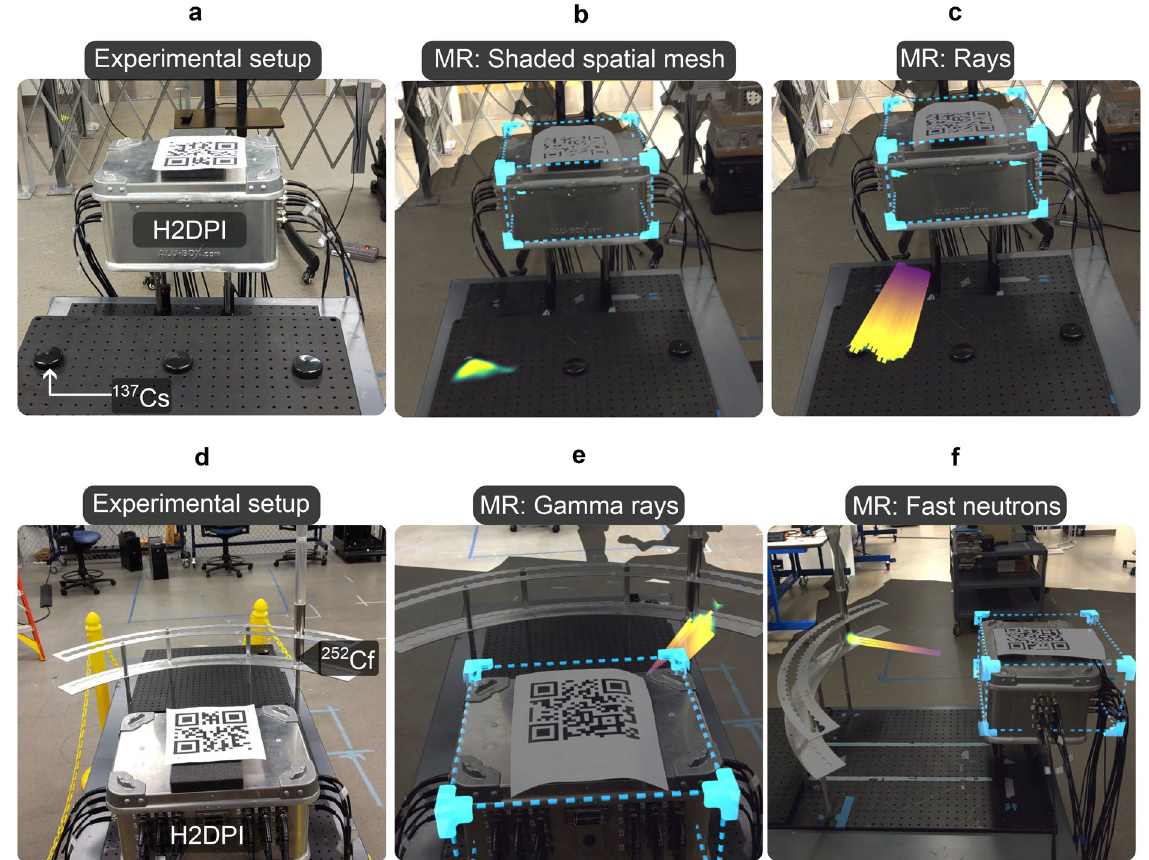
Figure 3. Examples of the mixed reality visuals as seen by the user wearing the HoloLens2. ( a ) A 100 µ Ci 137 Cs source is set under one of three caps in front of the detector system. ( b ) In MR, the user is shown a coloring of the spatial mesh after about 30 seconds of acquisition. ( c ) The user may optionally choose to also display rays that point to the hot spot. ( d ) A 1 mCi 252 Cf source in front of the system. ( e ) The gamma ray image forms within approximately 20 seconds. ( f ) The user can switch to the (simultaneously acquired) neutron image via a wrist menu. A converged neutron image that intersects with the expected source location is seen after around one